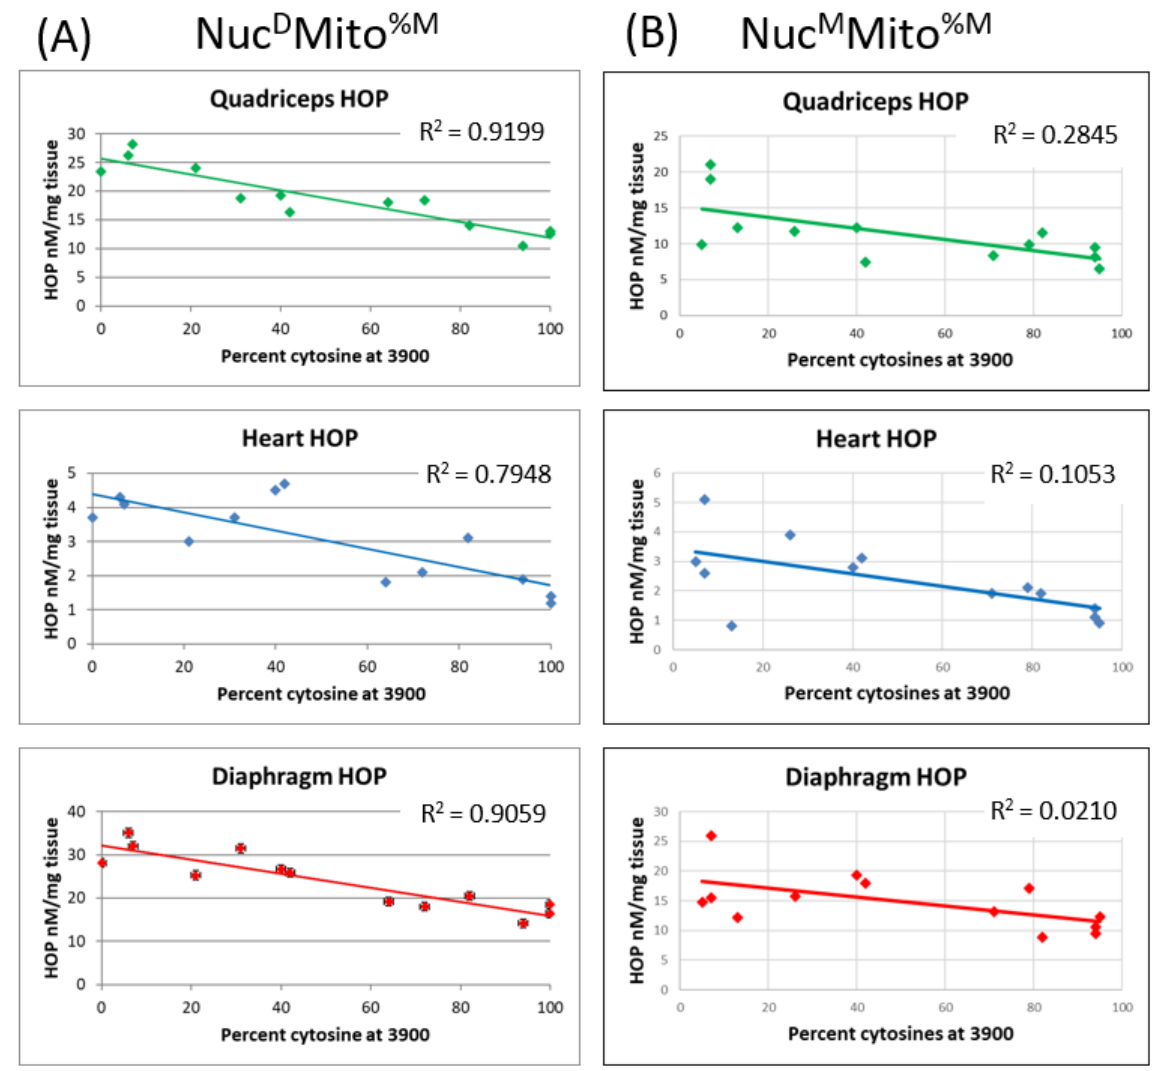
Figure 5. The cytosine mutation at nucleotide 3900 segregates with decreased fibrosis. The percentage of MRL cytosine at position 3900 correlates inversely with fibrosis, in quadriceps, diaphragm and cardiac ventricles: p < 0.05 for all three tissues. ( A ) This is true in the mice with D2 nuclear genomes and ( B ) mice with MRL nuclear genomes.